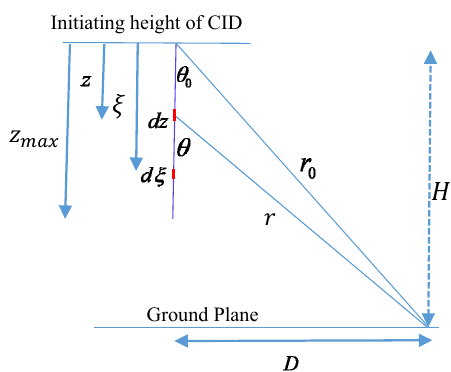
Figure 7. Geometry necessary for the calculation of the velocity field generated by the streamer burst.